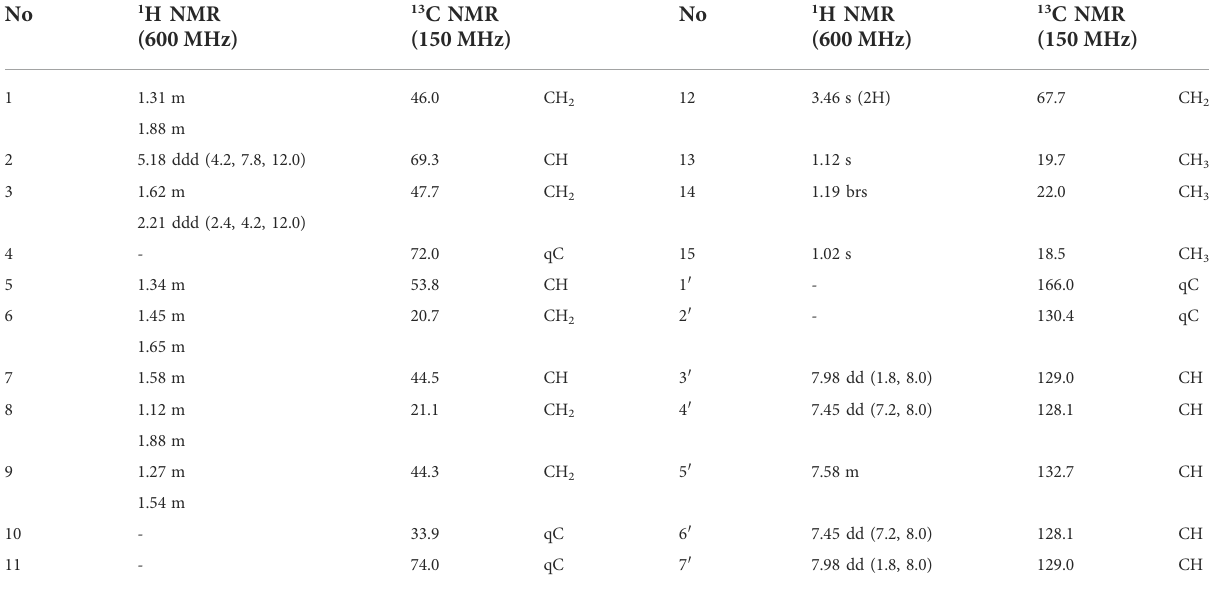
TABLE 3 1 H- and 13 C-NMR spectroscopic data of 7 in methanol- d 4 .